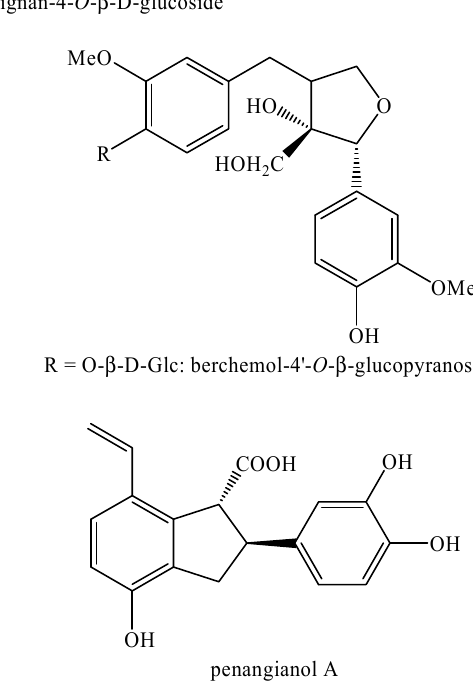
Figure 14. Isolated nor -lignans in the plant kingdom—part 13.